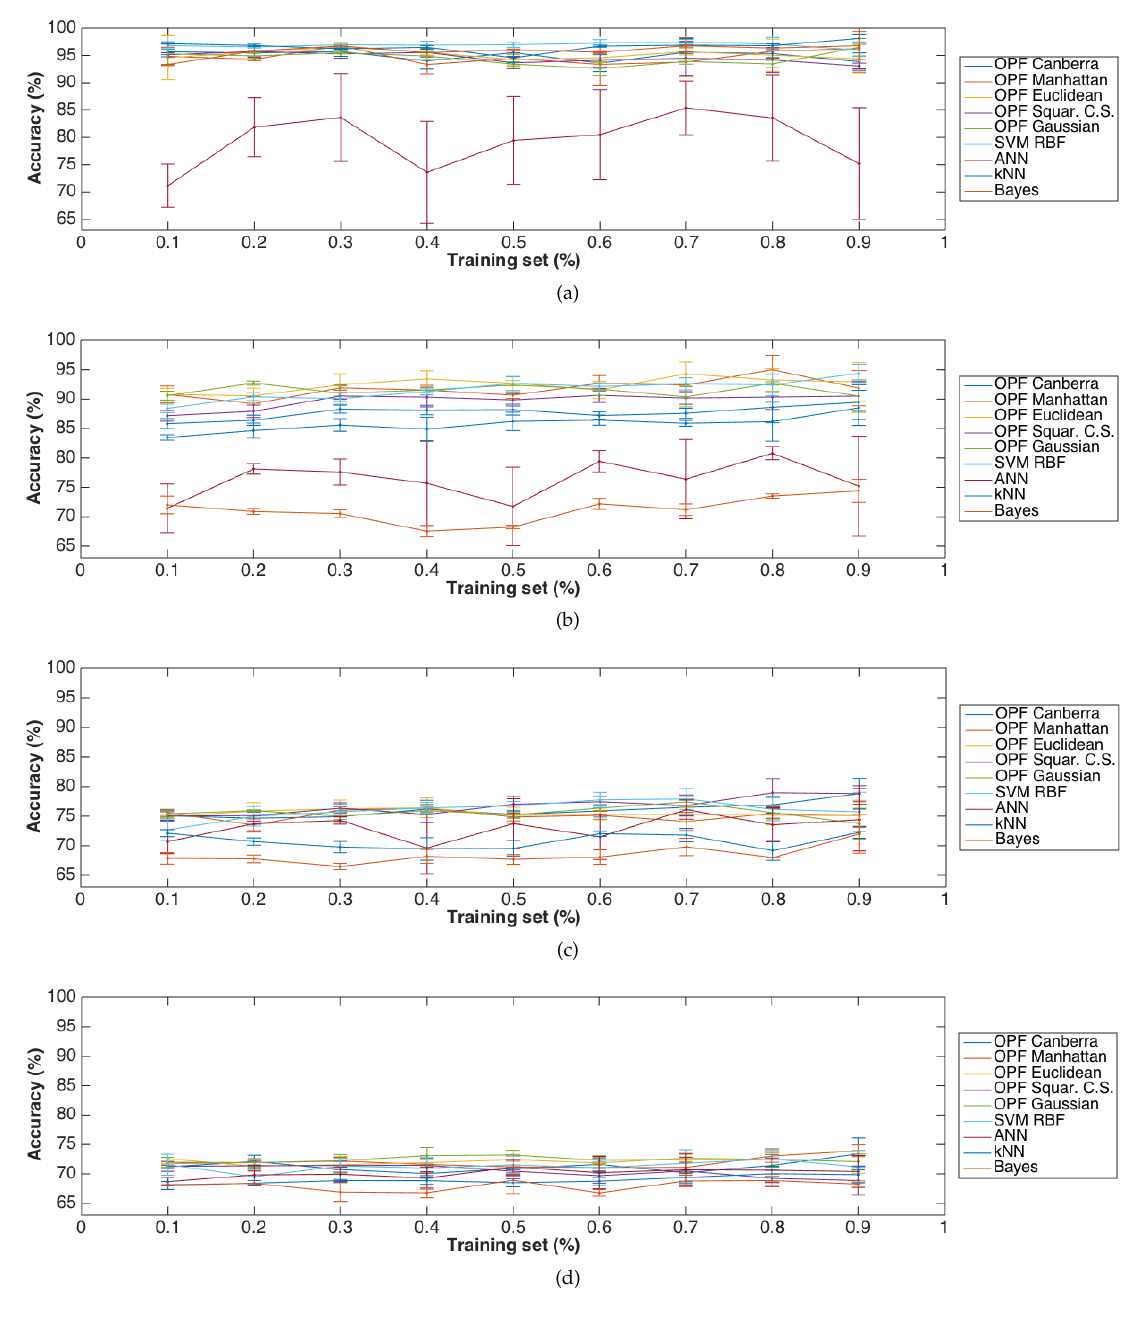
Figure 6. Accuracy obtained by the computer classifiers varying the used training data from 10% to 90% when applied on the original data and on the same data corrupted with the addition of Gaussian noise: ( a ) 0% (raw data); ( b ) 5%; ( c ) 15%; and ( d )